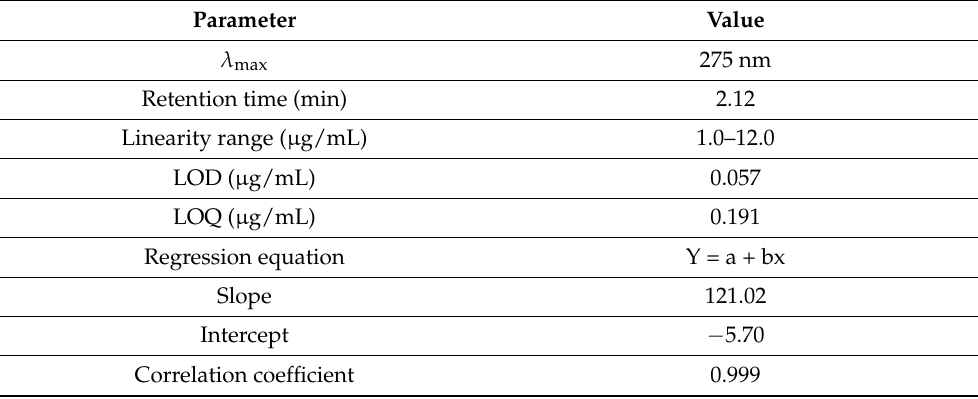
Table 2. Accuracy results for fasudil in the standard solutions.